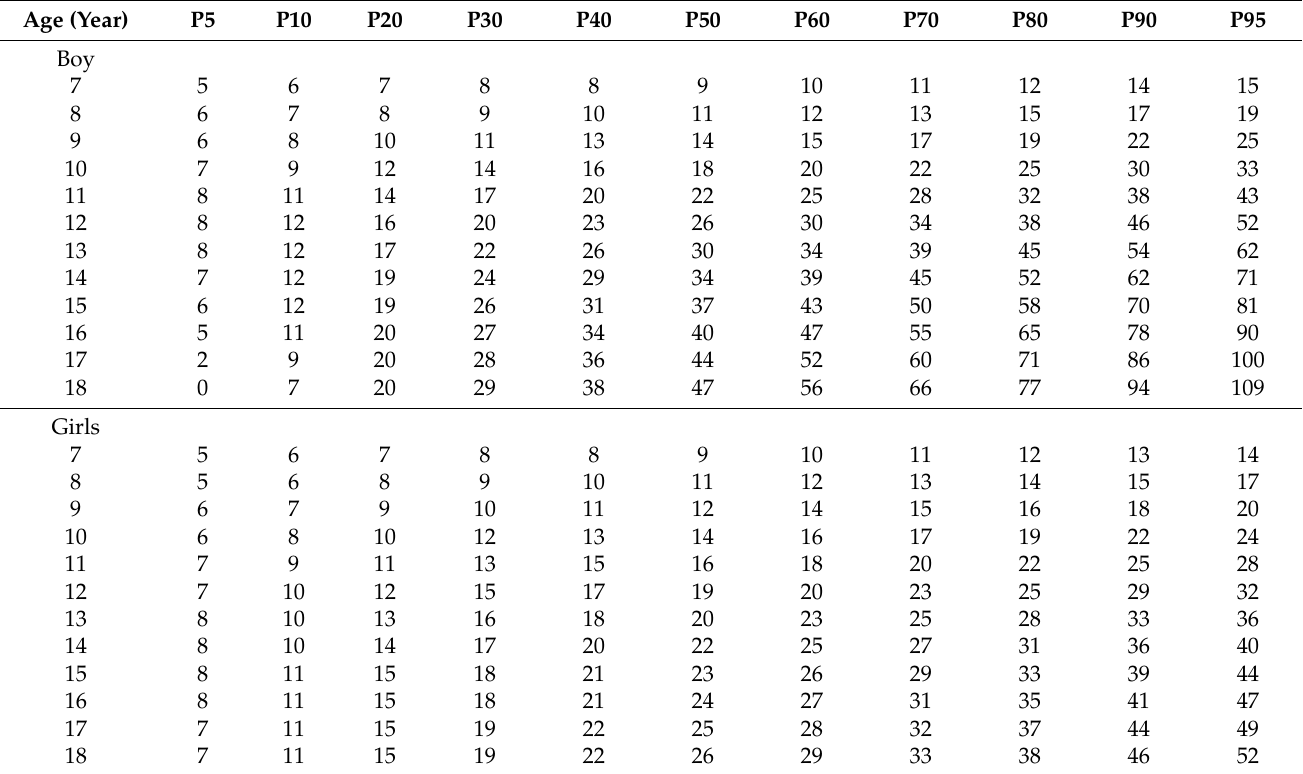
Table 1. Percentile values of laps for Chinese Tibetan children and adolescents aged 7–18 in Ti- bet,